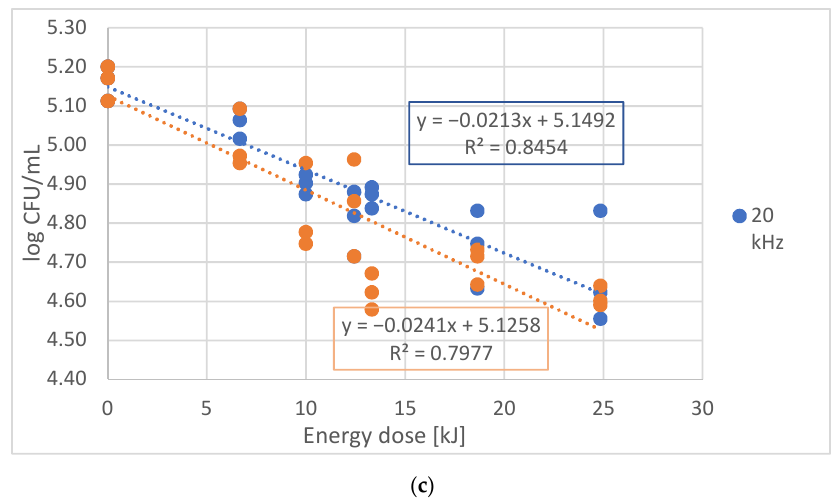
Figure 5. Linear regression of log CFU/mL (y) by the energy dose (x) of the treatment separately for 20 kHz and 40 kHz (( a ) albumen, ( b ) yolk, ( c ) liquid egg). Table 1. Slopes values, standard deviation (SD) of the slopes, F values and coefficient of determination (R 2 ) values of the